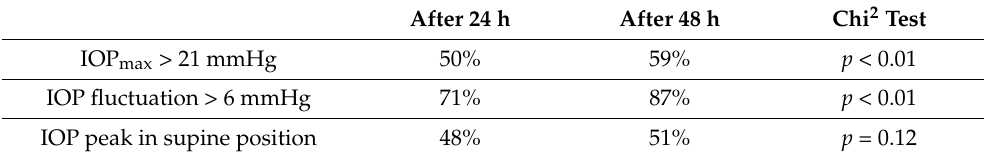
Table 1. Fractions of IOP profiles that met the predefined criteria for the 24 h and the 48 h group. After 24 h After 48